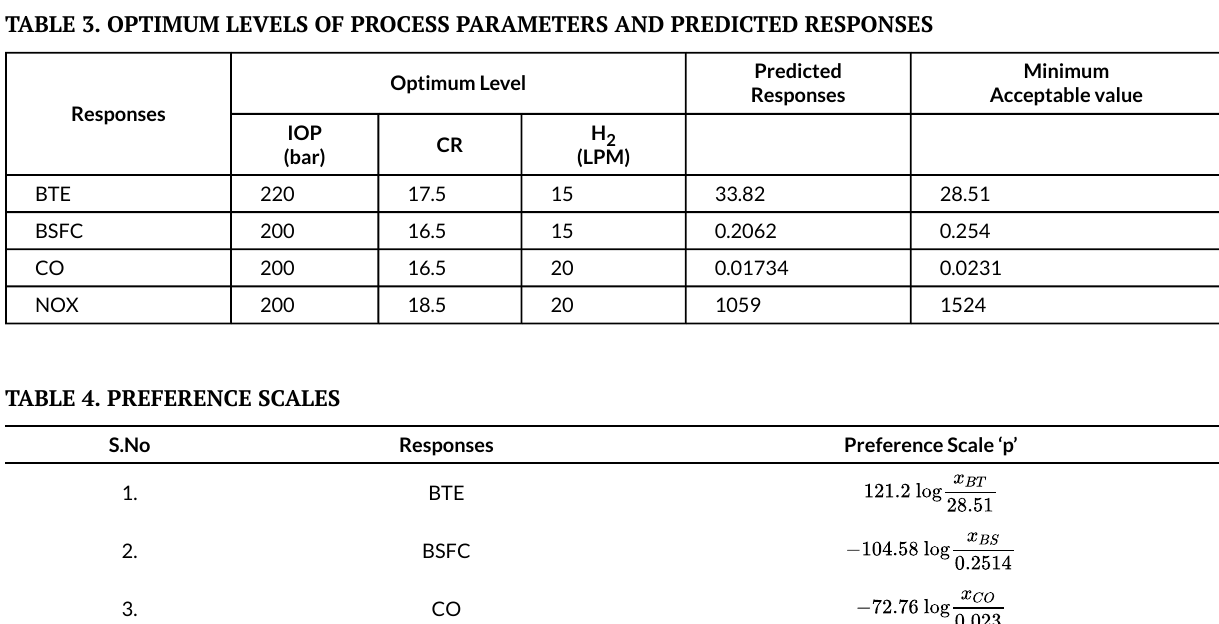
TABLE 3. OPTIMUM LEVELS OF PROCESS PARAMETERS AND PREDICTED RESPONSES